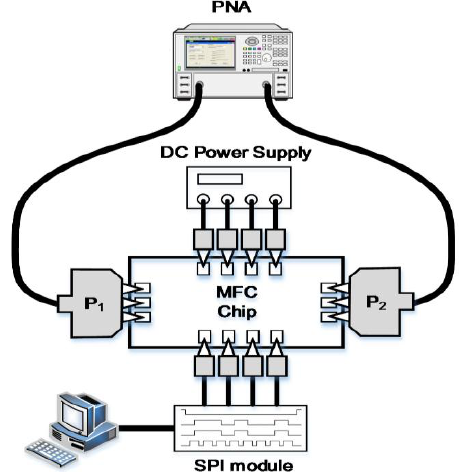
Figure 18. The block diagram of S-parameters, phase and attenuation response measurement setup as a function of the control bits.